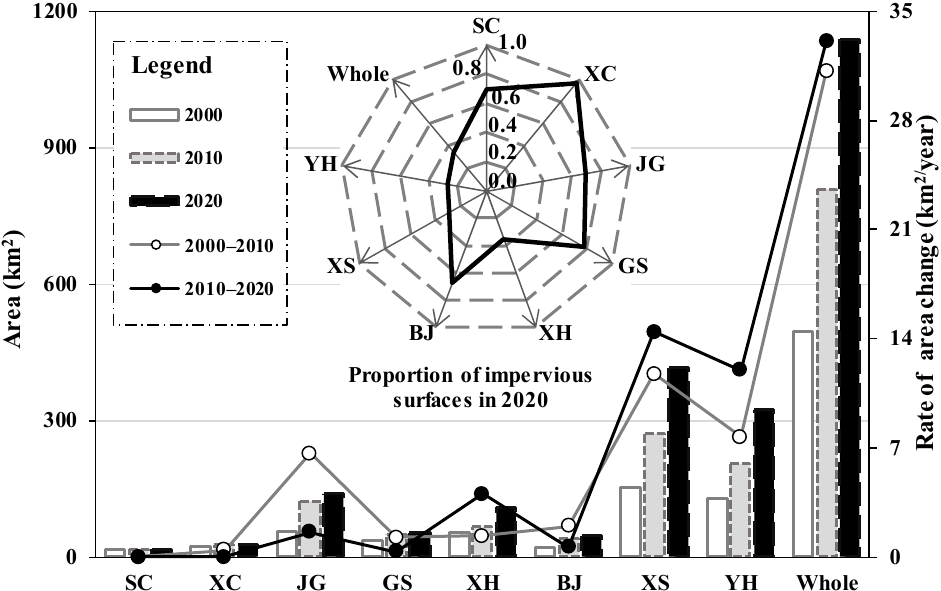
Figure 4. Growth of impervious surfaces in Hangzhou City from 2000 to 2020. The polar plot shows the proportions of impervious surfaces in the study area and the districts in 2020. SC, XC, JG, GS, XH, BJ, XS, and YH are abbreviations for the Shangcheng, Xiacheng, Jianggan, Gongshu, Xihu, Binjiang, Xiaoshan, and Yuhang districts, respectively.